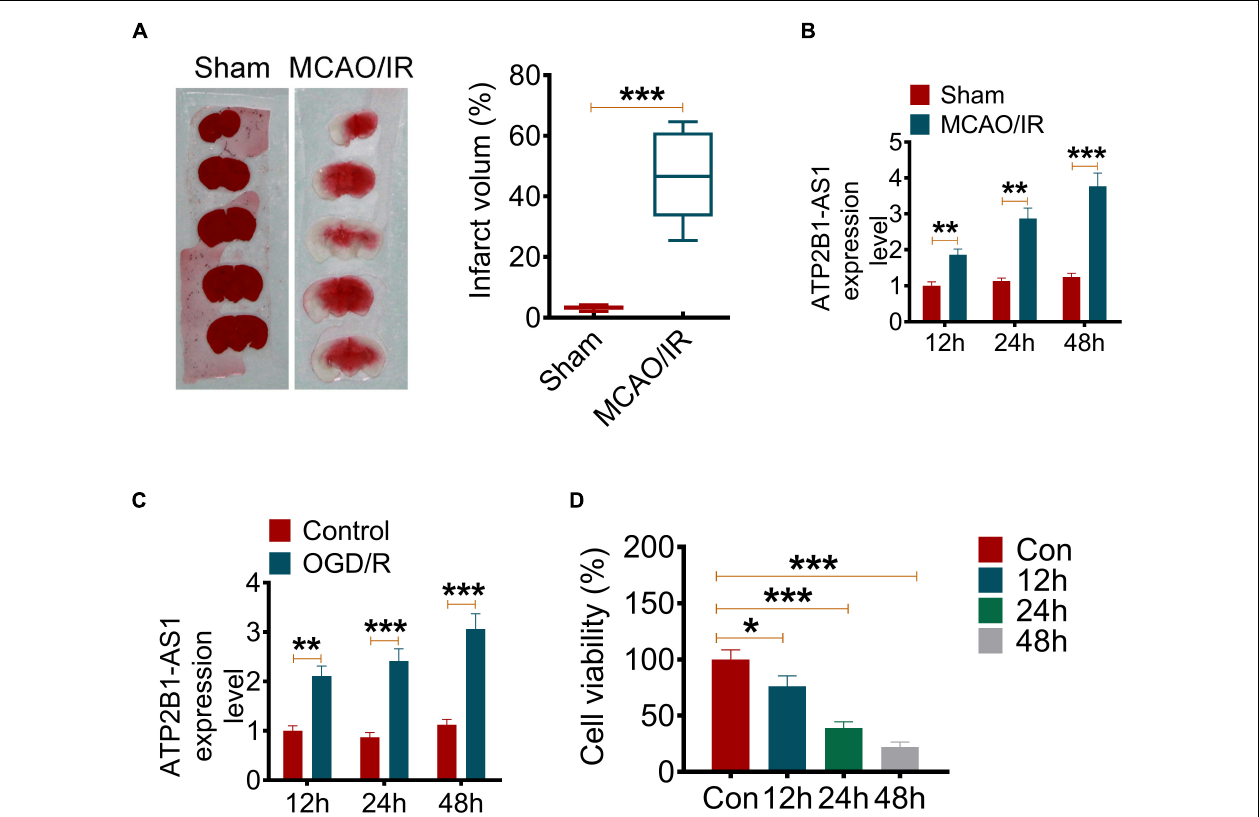
FIGURE 1 | The ATP2B1-AS1 expression in MCAO/IR rats and OGD/R PC12 cells. (A) The cerebral infarct volume was detected by TTC staining. The representative images of brain slices of the Sham and MCAO/IR group rats are present on the left and the quantification of infarct volume on the right. (B) The mRNA expression of ATP2B1-AS1 in MCAO/IR rats for reperfusion for 12, 24, and 48 h was determined by qRT-PCR. (C) The mRNA expression of ATP2B1-AS1 in OGD/R PC12 cells for reoxygenation for 12, 24, and 48 h was determined by qRT-PCR. (D) The cell viability of OGD/R PC12 cells for reoxygenation for 12, 24, and 48 h was determined by the MTT method. * P < 0.05, ** P < 0.01, *** P <